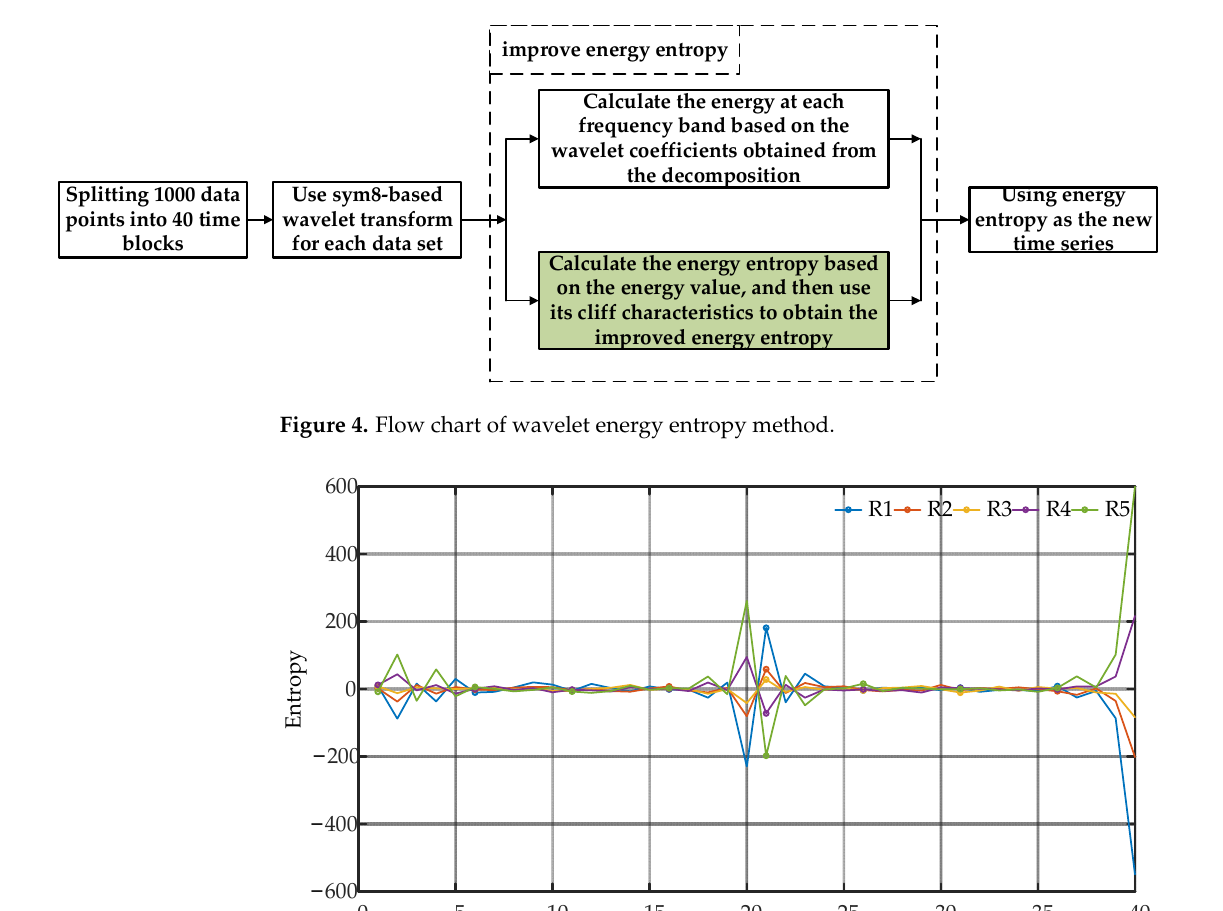
Figure 5. Improved energy entropy of different categories.